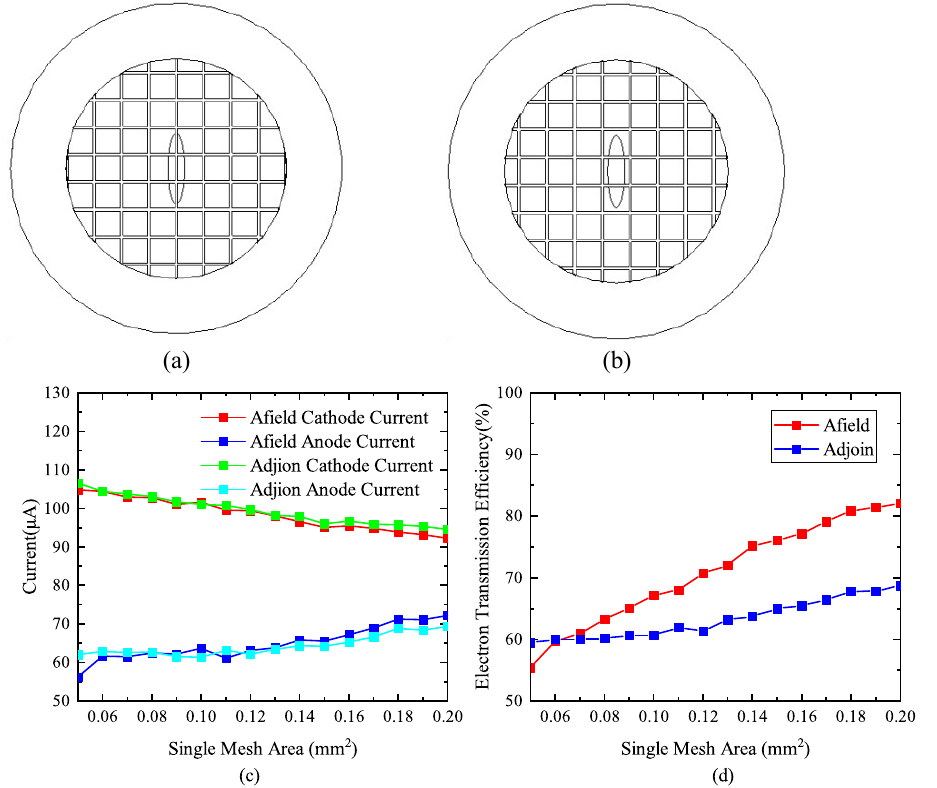
Figure 6. Influence of grid projection distribution on cathode surface on cathode current, anode current, and electron transmission efficiency. ( a ) Grid projection in the long axis of cathode. ( b ) Grid projection away from cathode long axis. ( c ) The influence of different grid wire projection positions on cathode current and anode current. ( d ) The influence of different grid wire projection positions on electron transmission